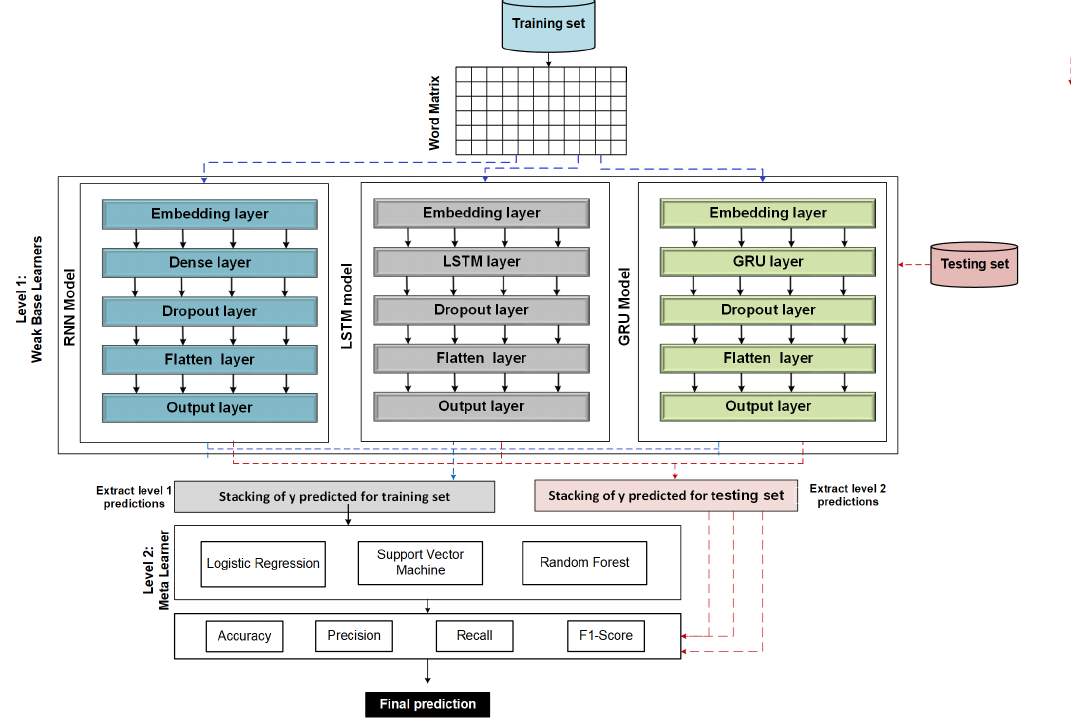
Figure 6. The architecture of the proposed stacking ensemble